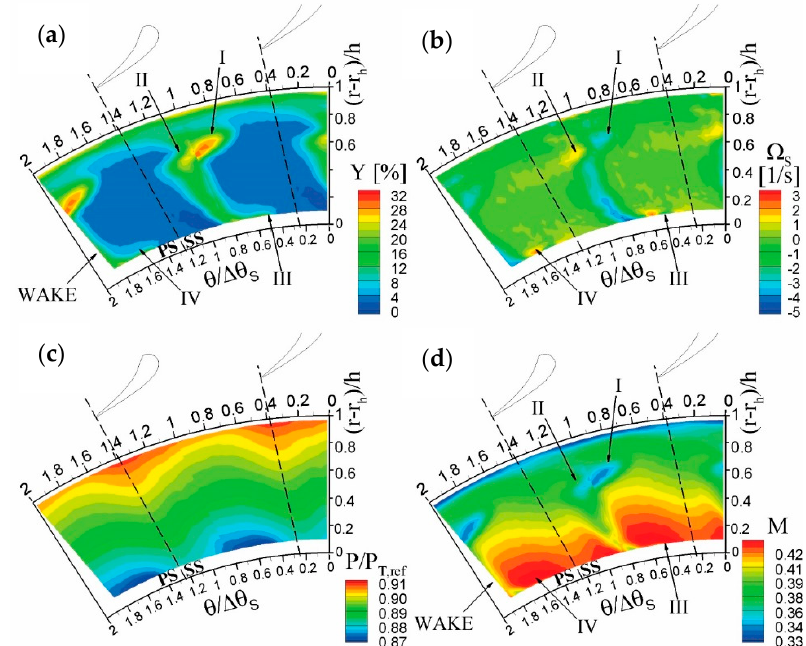
Figure 4. Stator-exit flow field in OP4, ( a ) total pressure loss coefficient; ( b ) streamwise vorticity; ( c ) local expansion ratio; ( d ) absolute Mach number.